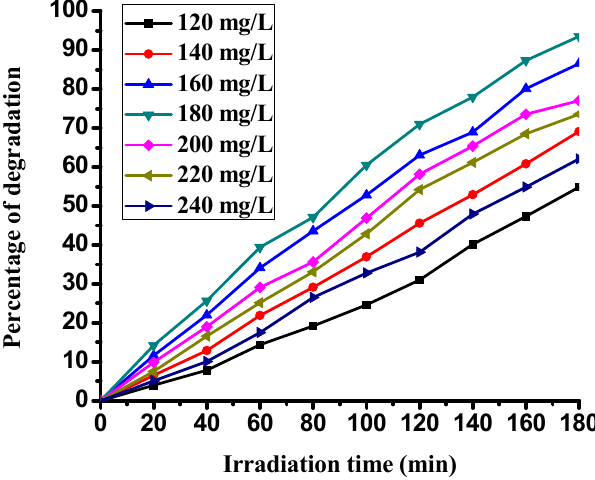
Figure 5. Optimization of N-Cu 2 O / ZnO nanocomposite loading for the degradation of methyl red under sunlight.